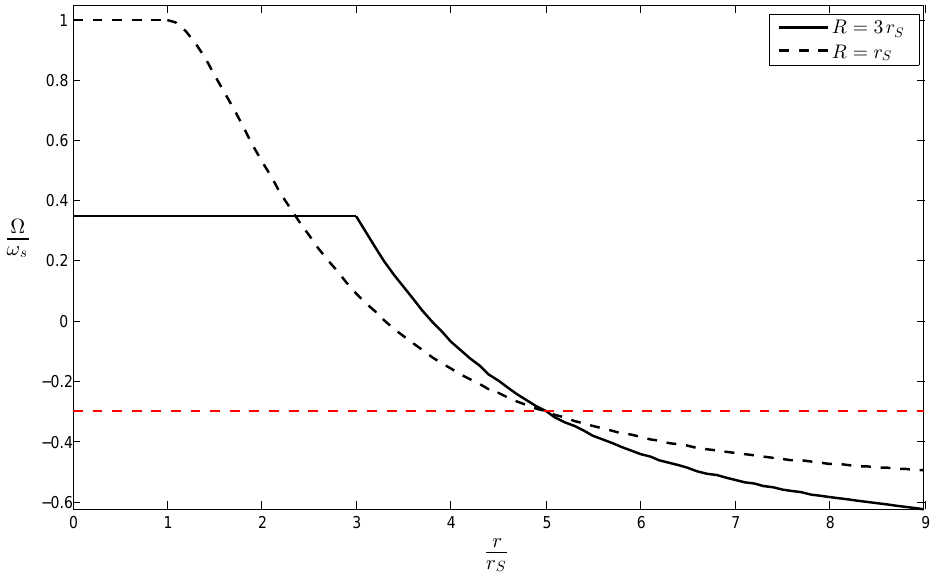
Figure 1. Plots of the angular velocity Ω ( r ) of ZAMOs, as given by the expression in Equation (34), with Ω Q = − 0.3 ω s and r Q = 5 r S . Note that Ω ( r ) is normalized by ω s . The solid curve shows the result for a shell radius R = 3 r S . The black dashed curve shows the result for a shell radius equal to its Schwarzschild radius, R = r S . This corresponds to the situation of “perfect inertial dragging”, where the inertial frames in the interior of the shell rotate with the same angular velocity as the shell, independently of the angular velocity of the inertial frames located “at infinity”. The red dashed curve marks the chosen value for Ω Q (normalized by ω s